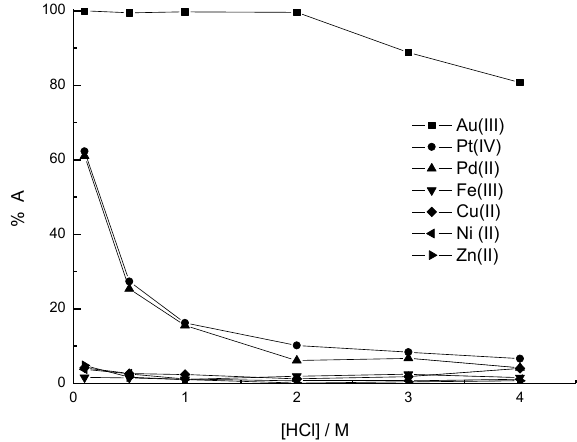
Figure 28. Percentage adsorption of various metal ions on DMA-PW gel from varying concentration (mol·dm −3 ) of hydrochloric acid solution [36] (with permission for reuse from Elsevier